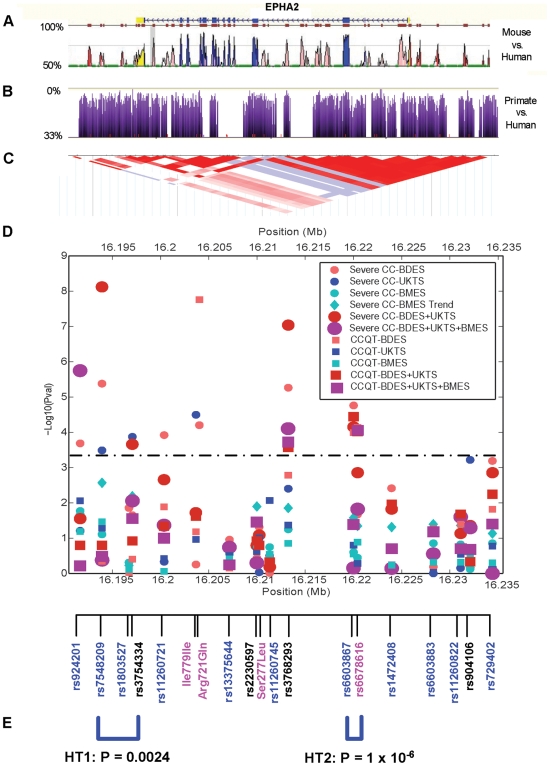
Single SNP and haplotype association results for EPHA2.Markers were selected based on phylogenetic footprinting in mouse-human (A), or phylogenetic shadowing in human-primates (B), or a tag-based approach using LD from the CEU HapMap sample (C). Markers in blue are in phylogenetically conserved areas, in black are tag-based, and in pink are identified via re-sequencing (D). Single marker results are reported using the full range of quantitative cortical cataract scores (CCQT) and the extreme phenotypic contrast for cortical cataract (severe CC), from the BDES, BMES, and UKTS. Meta-analysis results are shown using the two family studies (BDES and UKTS) and using all three studies (BDES, BMES, and UKTS). We plotted −log10(P value) from the likelihood ratio test for CCQT and severe CC at each marker (D). The dashed line represents the 0.05 P value after adjusting for multiple testing for the genotyped SNPs and multiple models (0.05/[19 markers×3 genetic models×2 traits] = 4×10−4). (E) Window sizes of 2–5 markers were used to identify the most significant haplotypes in the 3′ (HT1) and the 5′ (HT2) region using percent of the lens affected by cortical cataract in the BMES, the sample of unrelated persons.